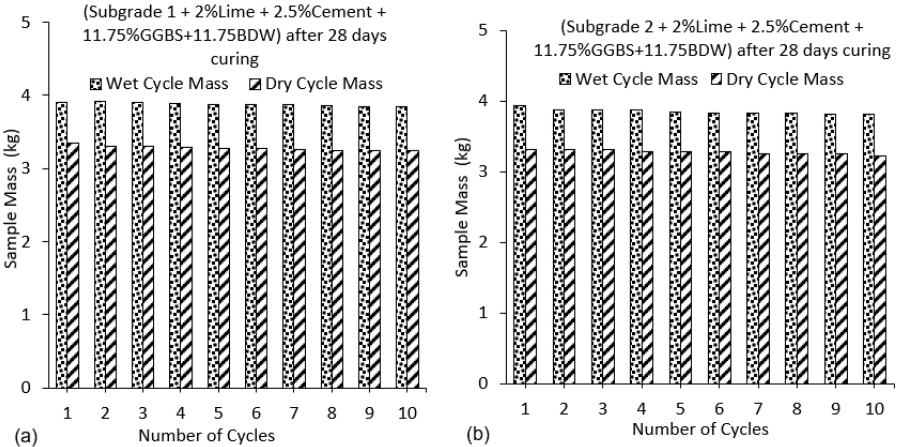
Figure 3. ( a ) Sample mass for subgrade 1 composed of GGBS and BDW after 28 days of curing ( b ) Sample mass for subgrade 2 composed of GGBS and BDW after 28 days of curing.